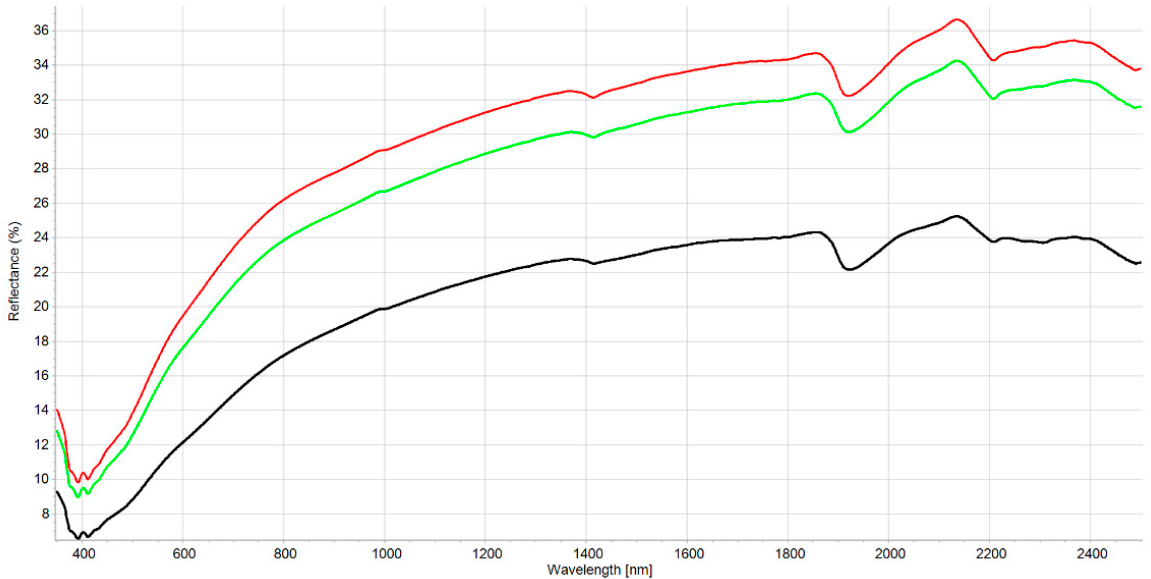
Figure 2. Mean reflectance spectra for the three classes of the PLS-SVM classifier. The three classes of BC content are represented low (0–0.7 g kg − 1 ) as green line: medium (0.71–2.0 g kg − 1 ) red line and: high (>2.01 g kg − 1 ) black